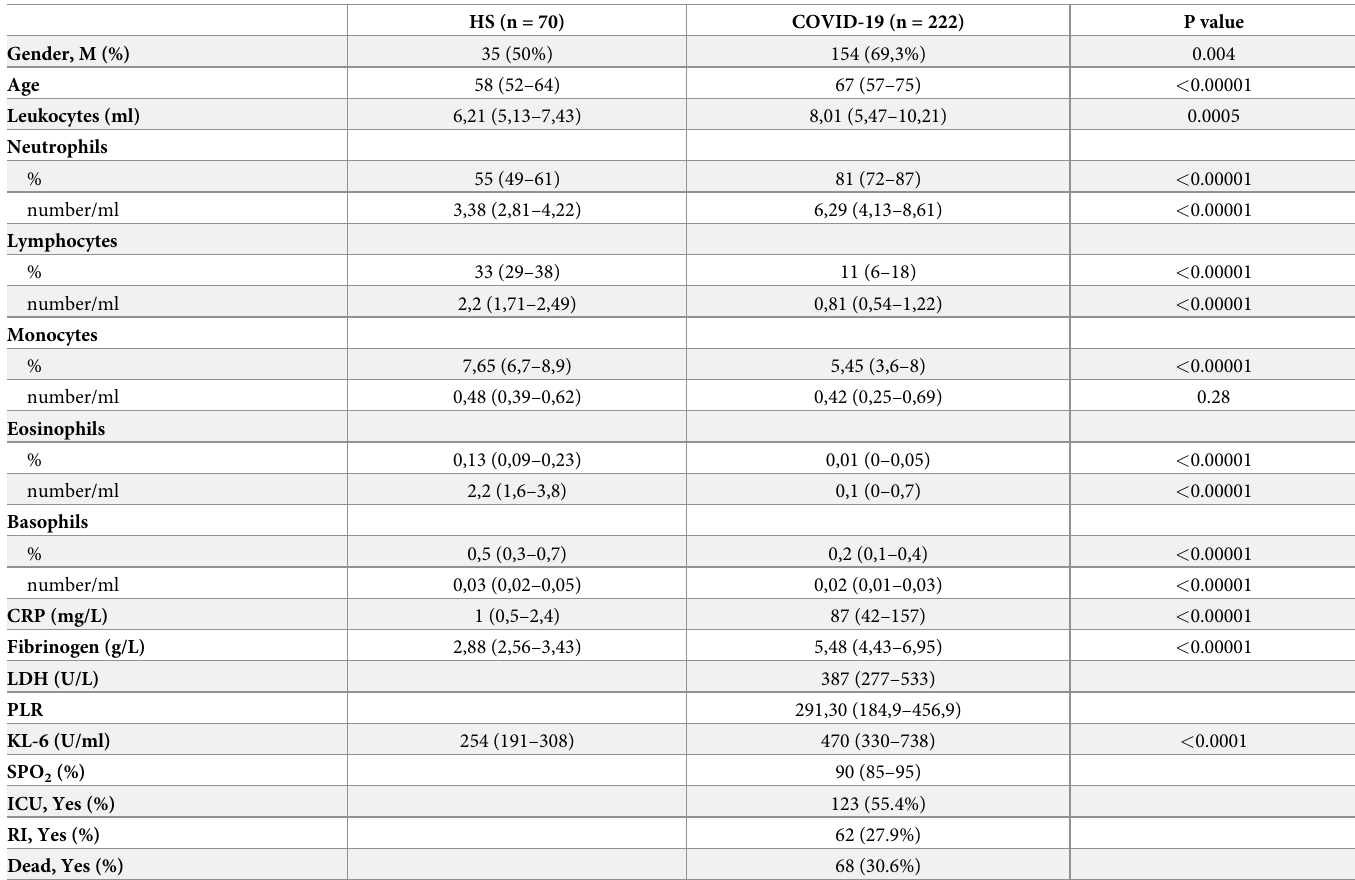
Table 1. Demographic and clinical characteristics of HS and COVID-19